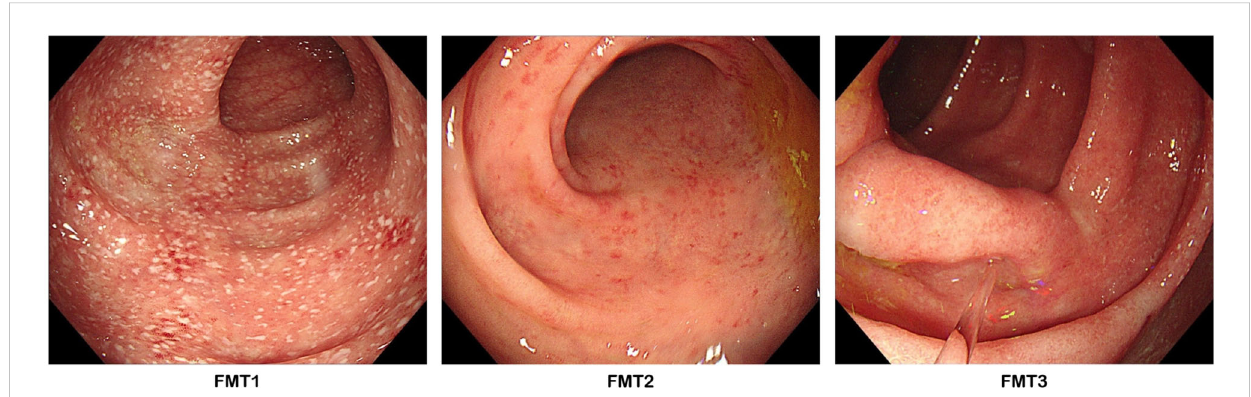
FIGURE 2 Colonoscopy photographs. FMT1 showing mucosal erythema, friability, erosions with white fur-like substance, and an obscure vascular pattern (Mayo endoscopic score = 2). FMT2 showing a milder degree of the above-mentioned characteristics (Mayo endoscopic score = 1). FMT3 showing an almost normal colonic mucosal appearance with faint in fl ammatory evidence (Mayo endoscopic score =